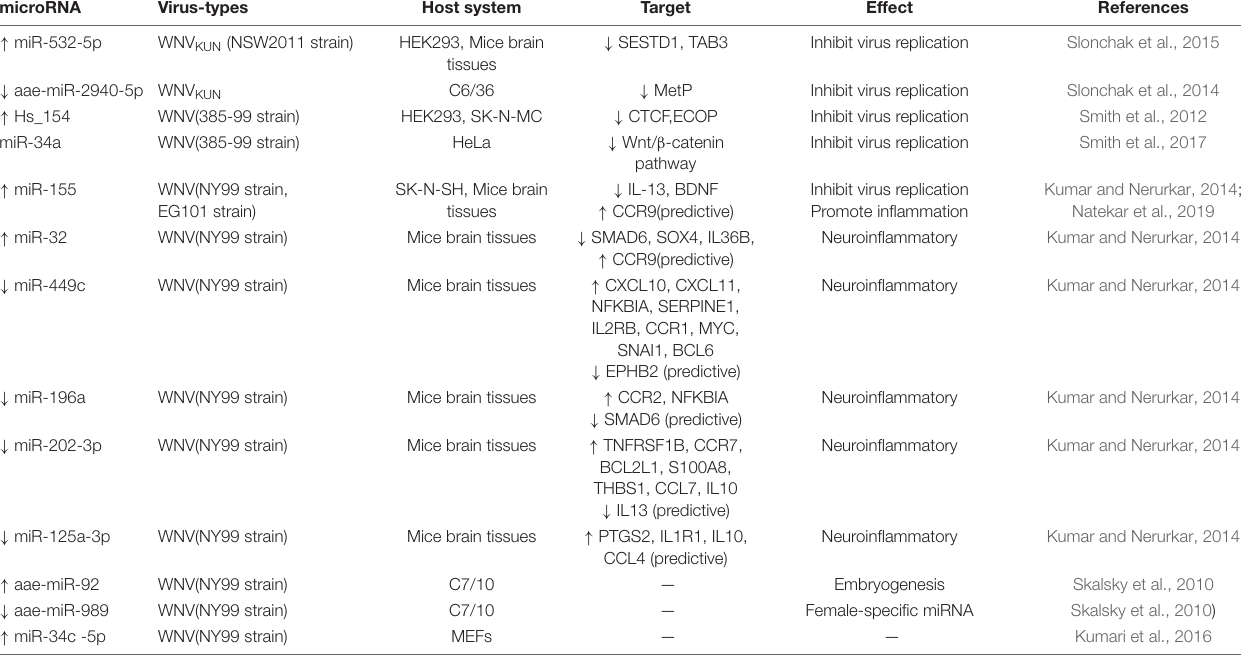
TABLE 3 | Differentially expressed miRNAs involved in WNV infection and their targets a